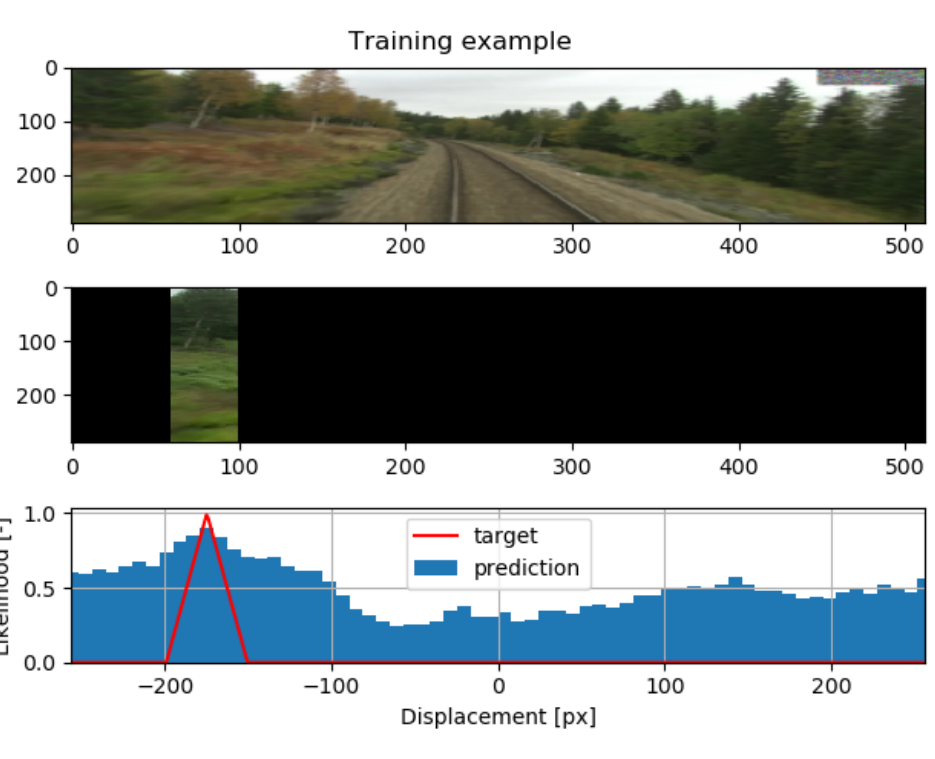
Figure 3. In this figure, we show the training procedure. We obtained a pair of corresponding images with seasonal variations from the training set. The second image is cropped, and the target is created accordingly. The target is set to one at its location on the first image and then decreases towards the cutout